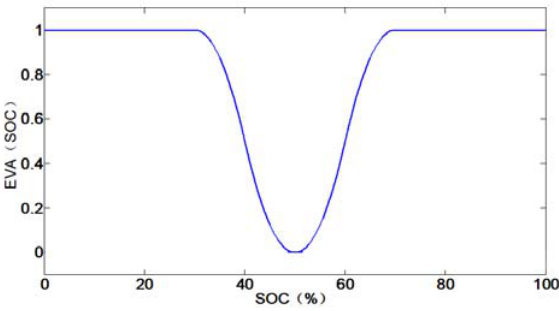
Figure 11. SOC penalty function.